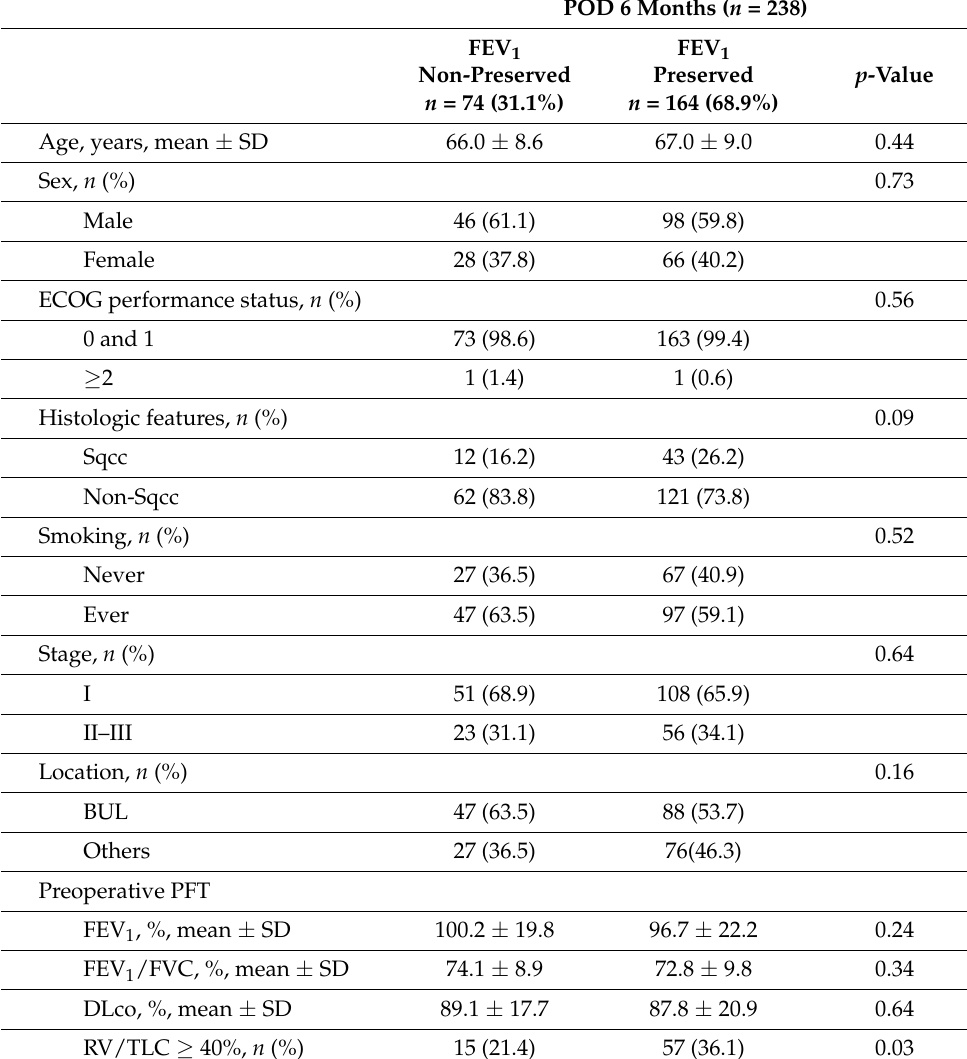
Table 2. Comparison between the FEV 1 non-preserved and preserved